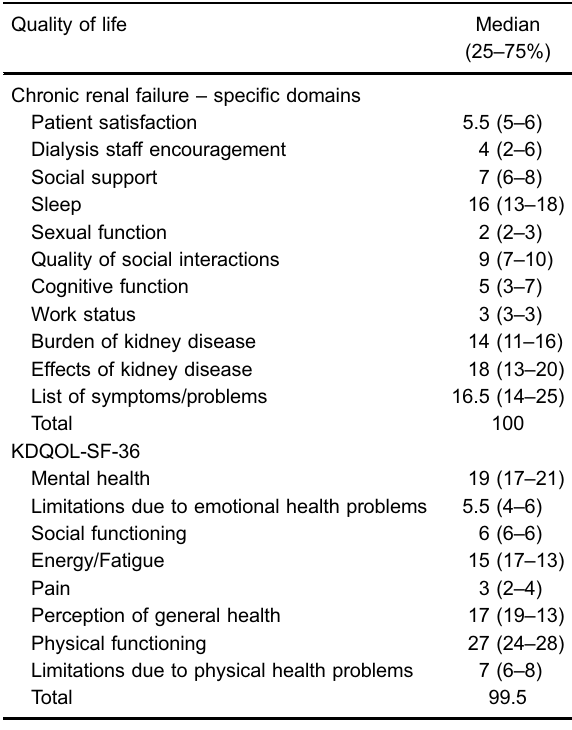
Table 2. Medians for items of the kidney disease quality of life short form 36 (KDQOL-SF 36) questionnaire. Quality of